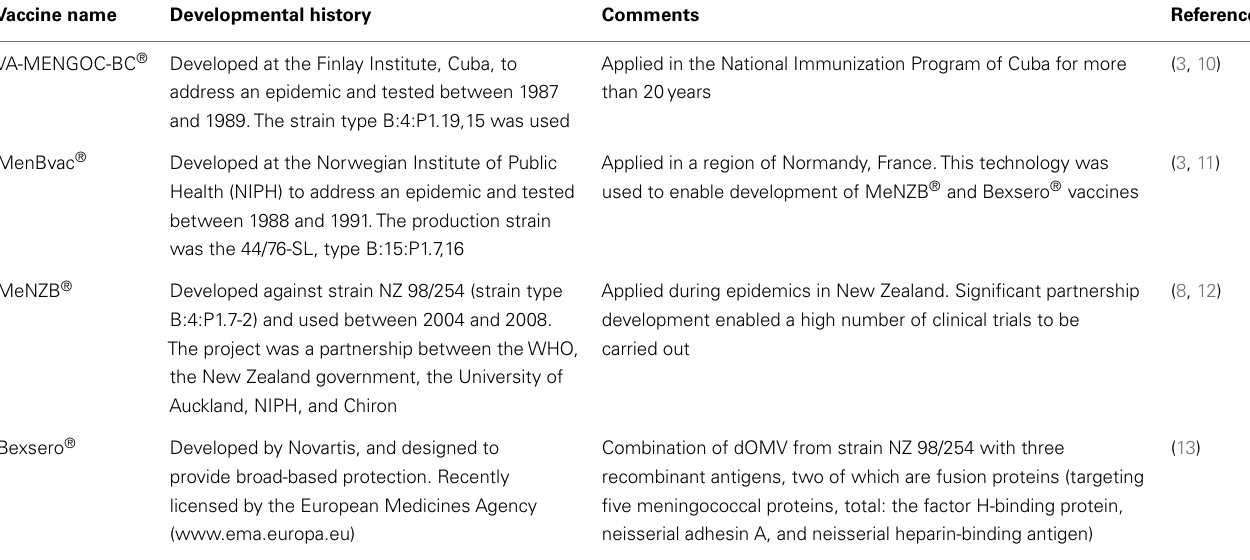
Table 1 | OMV vaccines from N. meningitidis serogroup